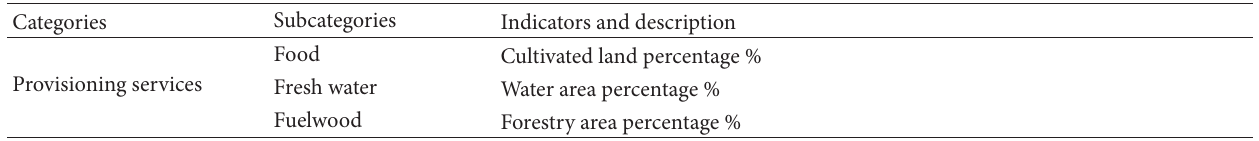
Table 1: Key ecosystem services indicators in the HRB.